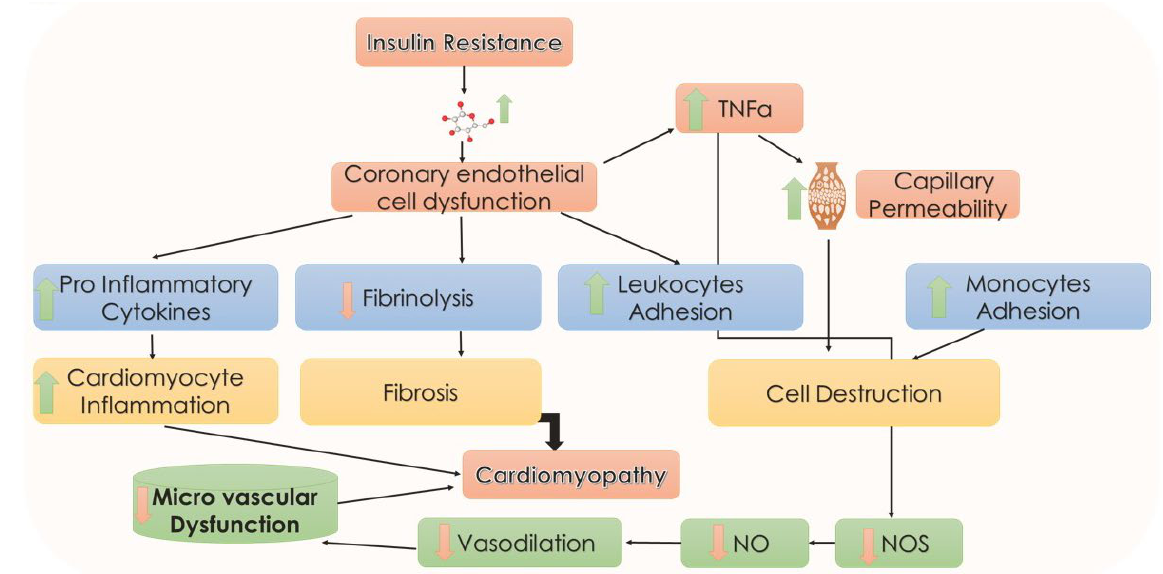
Figure 3. Insulin resistance and DCM. Coronary endothelial cell dysfunction may cause an increase in proinflammatory cytokines, TNF α , leukocytes, and monocyte adhesion and a decrease in fibri- nolysis. All these sequence events may cause a decrease in microvascular dysfunction in the heart. Arrows represent downstream events. NO, nitric oxide; NOS, nitric oxide synthetase; TNF α , tumor necrosis factor- α